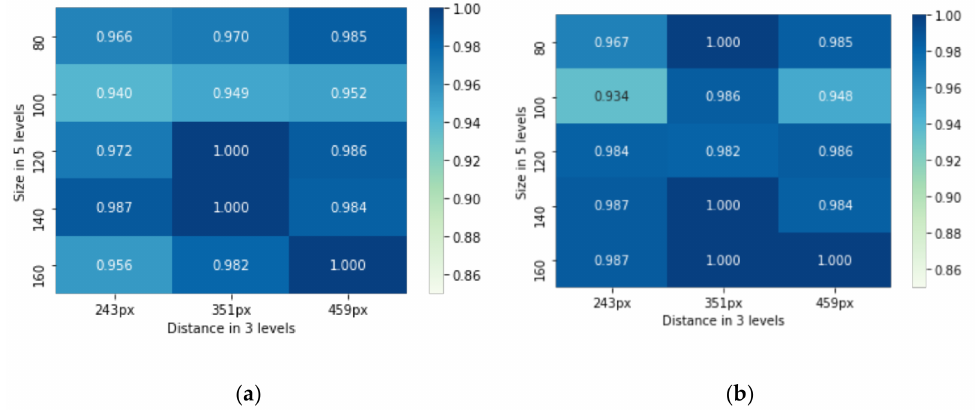
Figure 10. ( a ): Average correct rate of abstract icons; ( b ) average correct rate of concrete icons.